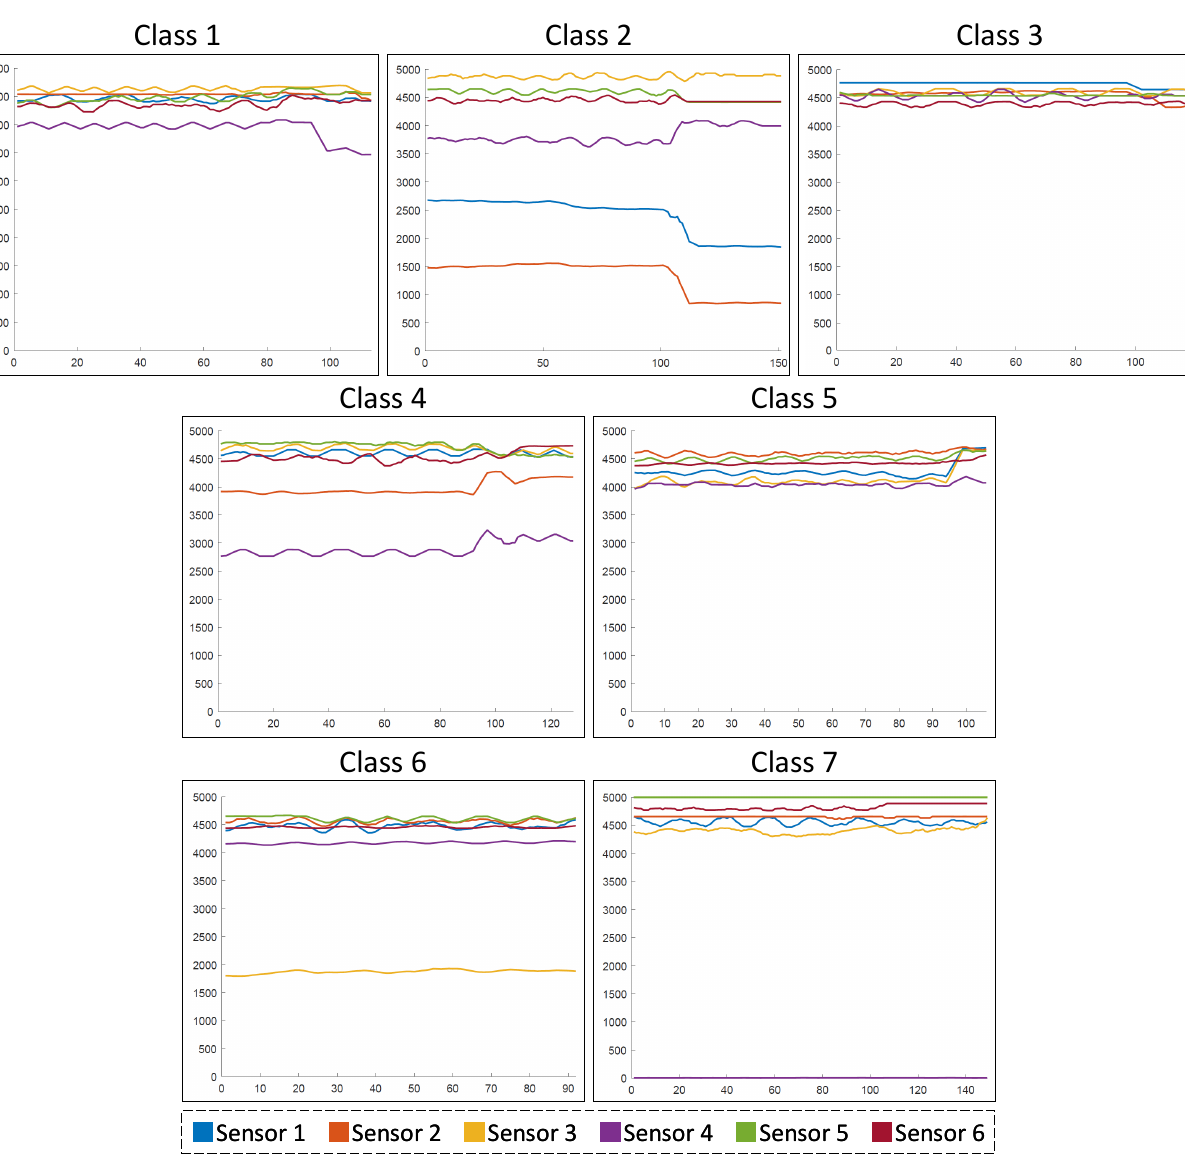
Figure 5. Data distribution distinguishing between the output of the six sensors for each class calculated on average for all the involved participants. These classes represent the seven postures considered for this work described in Table 1. Y axis represents the range of values that the sensors’ output could take, while X axis corresponds to the samples obtained over the recording time. Table 2. Accuracy results obtained on the different experiments that were performed. Several ANN models were evaluated, exploring different number of hidden layers (HL) and neurons per layer for each case, in order to search for the optimal configuration. The best result (highlighted in bold) is obtained for 2 HLs with 128 neurons per layer. No. of